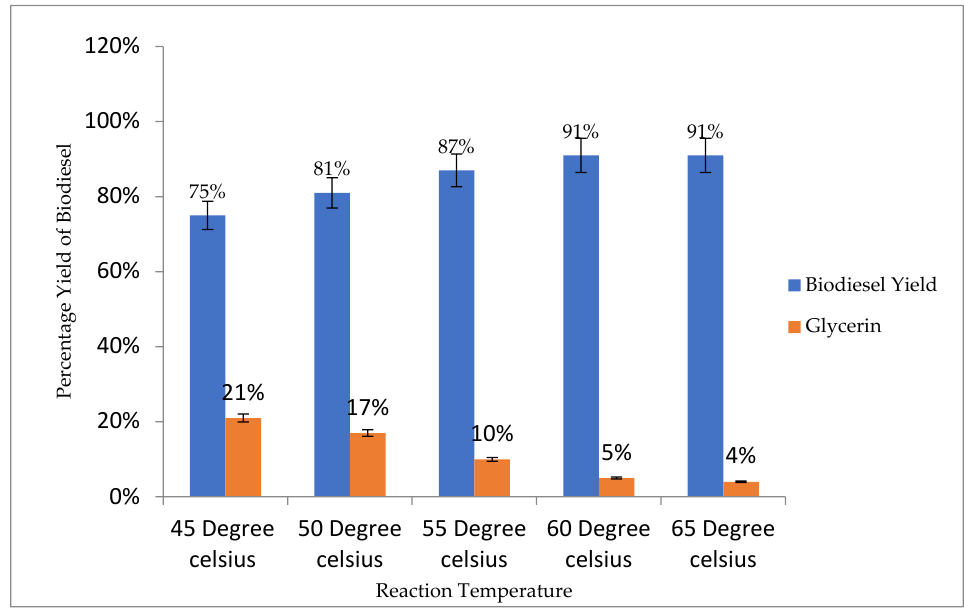
Figure 5. The influence of reaction temperature on biodiesel yield and on glycerin formation.